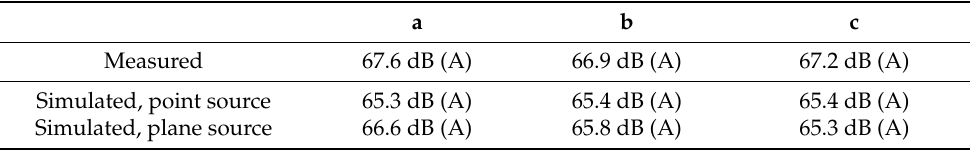
Figure 2. Measured and simulated SPLs at microphone positions, ( a ) a, ( b ) b, and ( c ) c, 1.2 m above the ground. Table 2. Comparisons of L A,eq between the measurement and simulation.